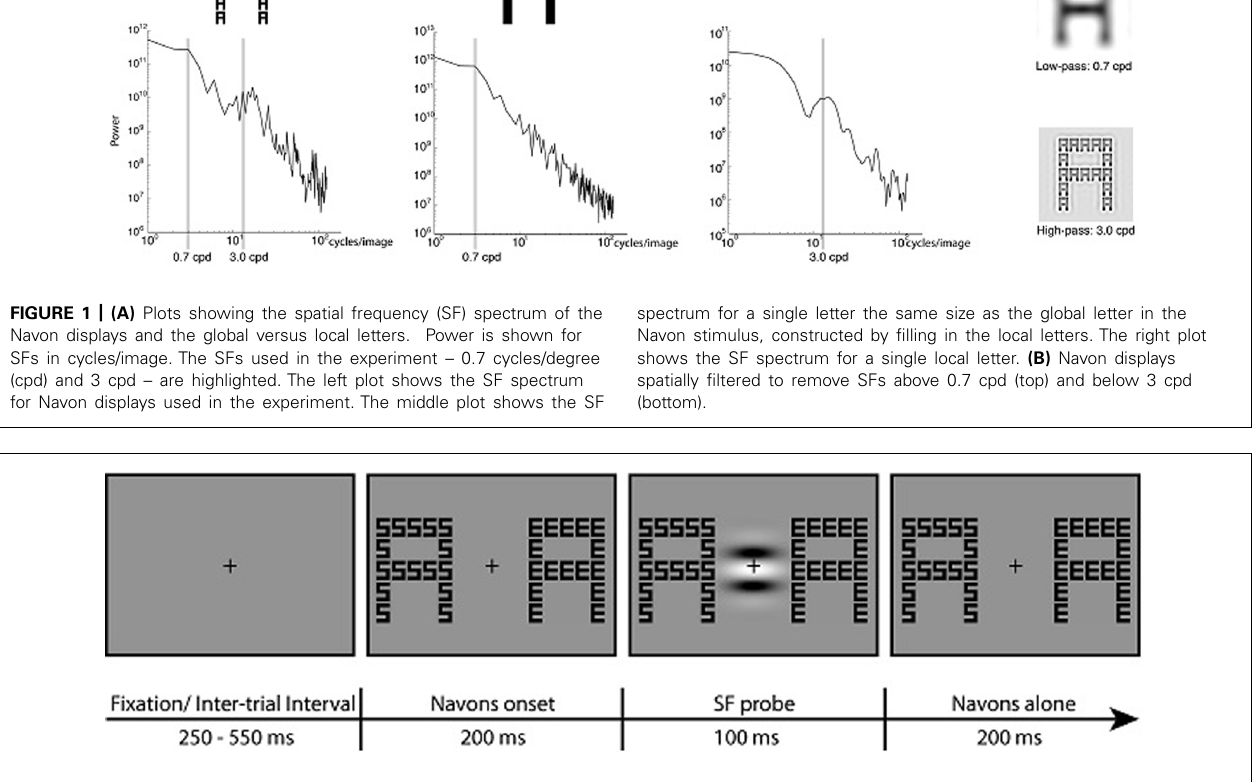
but not global attention task. In 2/3 of the trials, an irrelevant SF grating probe was flashed in the center of the screen 200 ms following the onset of the Navon stimuli. The probe was either LSF or HSF (LSF probe shown in the example). Participants were instructed to ignore the